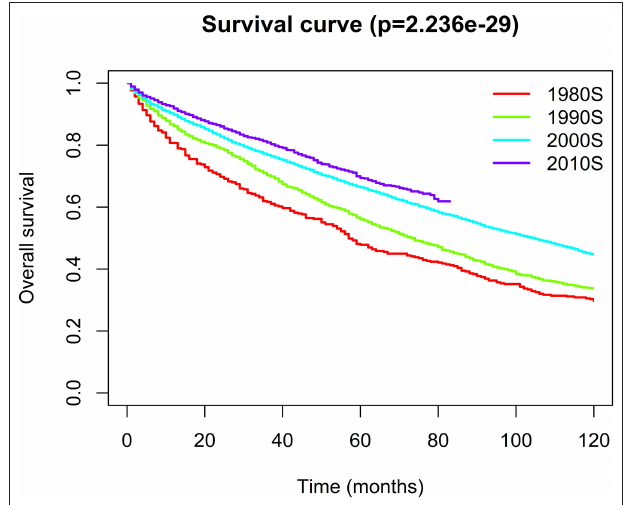
FIGURE 9 | Kaplan–Meier analysis for the overall survival of Waldenström macroglobulinemia. The graph shows increasing survival from the 1980s to